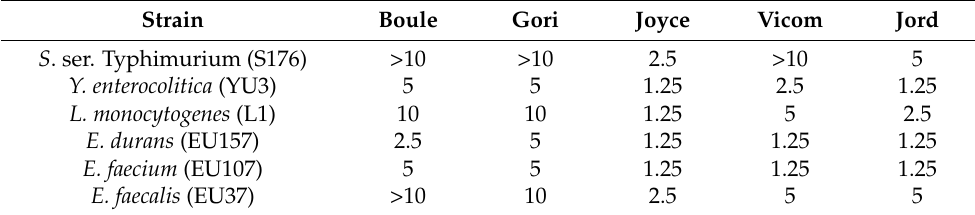
Table 4. MIC values (% v/v ) of the tested EOs against the selected bacterial